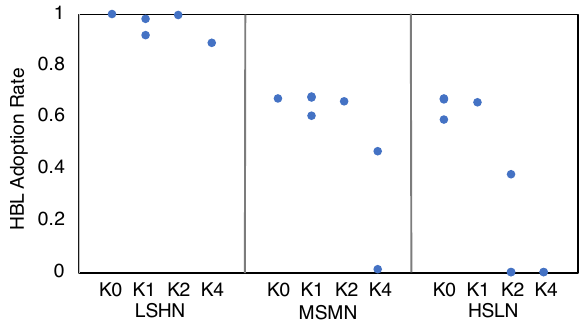
Figure 9. HBL adoption rate in equilibrium across different cloaking markets without